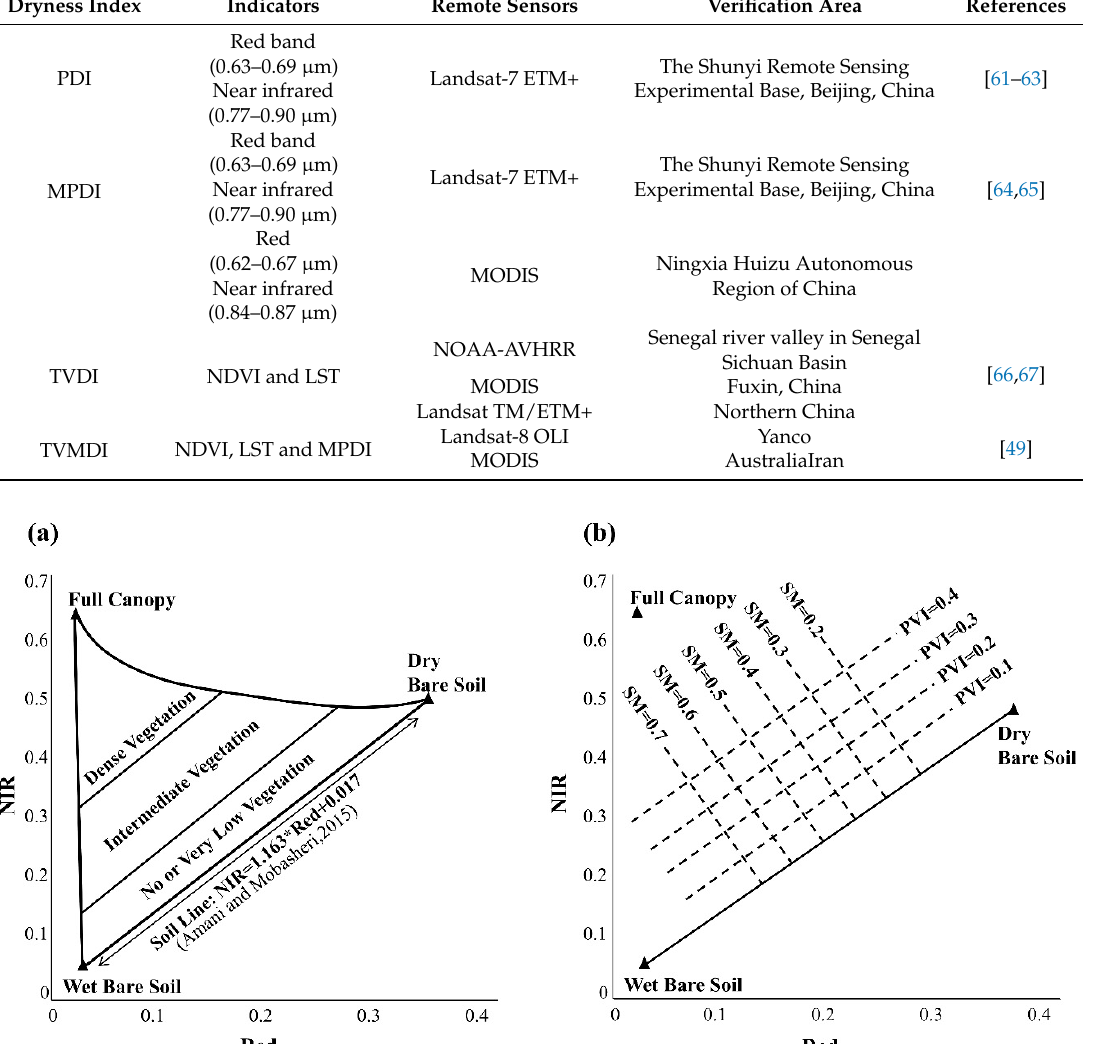
Figure 3. ( a ) The triangle distribution characteristics in the near-infrared (NIR)–Red spectral space. ( b ) The PVI and soil moisture (SM) iso-lines [49]. NIR and Red represent near-infrared and red band reflectance, respectively.